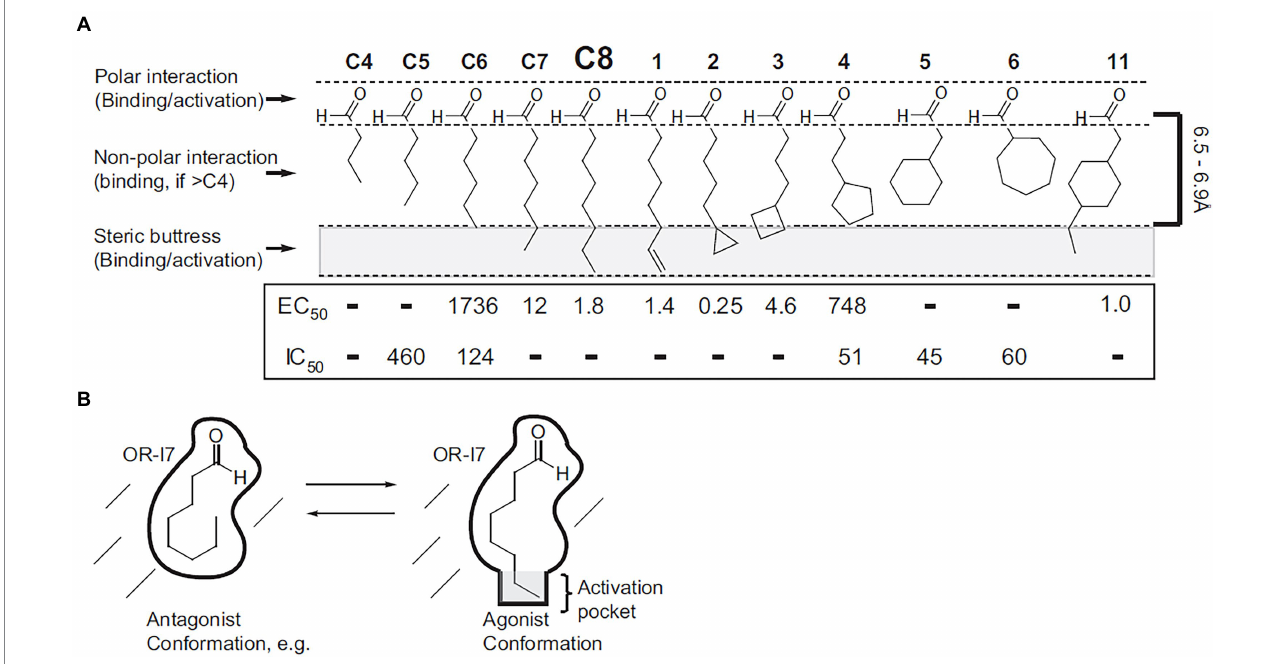
FIGURE 1 Using medicinal chemistry to determine the functional fragment required for odor activity. A series of conformation mimics were designed based on the structure of octanal, a known agonist of the odor receptor OR-I7. The biological activities of all chemicals were tested through calcium imaging of dissociated rat olfactory sensory neurons. (A) Structures, maximum lengths, and inhibition/activation constants. Regions of the structures responsible for binding and activation are indicated (left), as is the 6.5–6.9 Å length requirement for activation (right). Except for C4, which had neither type of activity, dashes in the IC 50 row indicate that the compound was not tested for antagonism because it is strongly activating. Dashes in the EC 50 row indicate that the compound had no activity within its solubility range. (B) Schematic depiction of octanal’s conformation on OR-I7’s activation. [Reprinted from Peterlin et al.